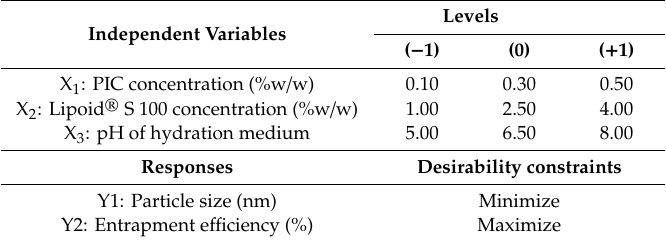
Table 1. Independent variables and responses used in the Box–Behnken design for the formulation and optimization Piceatannol-emulsomes (PIC-E).